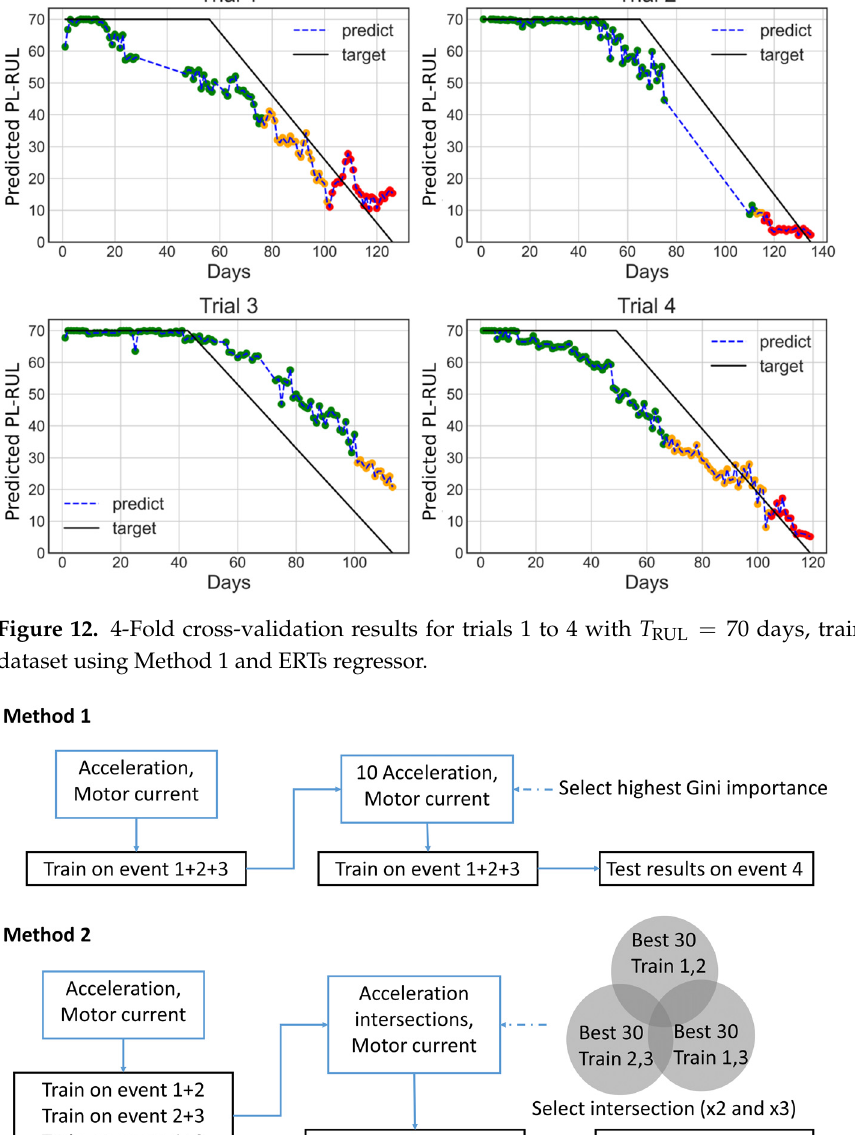
Figure 13. Two different methods for feature selection using an example of Trial 4 .